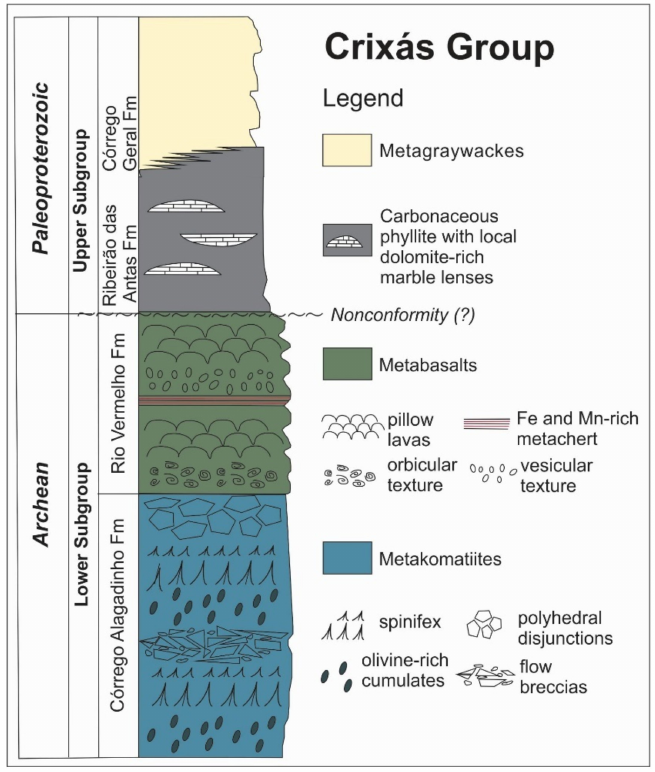
Figure 4. Stratigraphic section of the Crix á s Greenstone Belt modified from